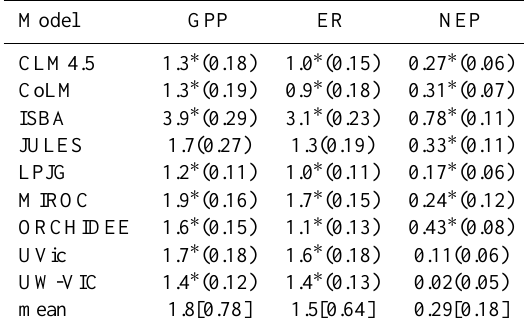
Table 6. Trend in GPP, ER, and NEP over simulation period for each model. Trend slopes (gCm − 2 yr − 2 ) are estimated using an auto-regressive AR[1] model to account for temporal autocorrela- tion. Standard error for the regression is indicated in ( ). Standard deviation of the model means is shown in [ ]. Significant trends ( p < 0.01) are denoted with an asterisk ( ∗ ).